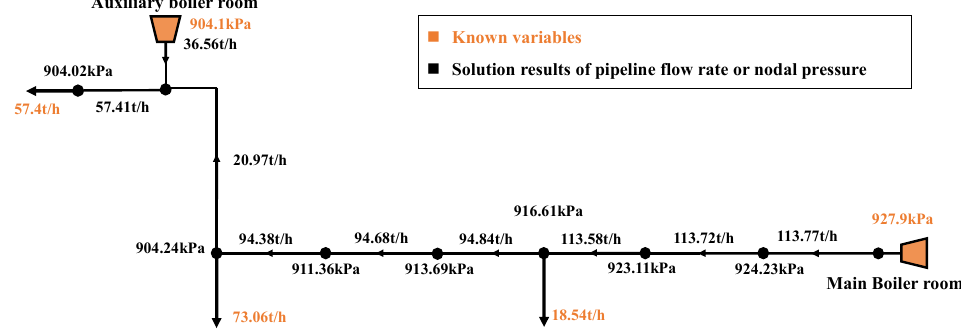
Figure 11. Simulation results of the nine-node double-heat-source tree steam heating network. SynerGEE gas is a relatively accurate commercial simulation software of the thermal system [15]. Using the simulation results of SynerGEE gas as a benchmark, flow verification of the proposed steam network model is carried out. Figure 12 compares the calculation results of the pipeline flow obtained by the proposed model and SynerGEE gas. The absolute error is within 1.6 t/h and the relative error is within 1.5%, indicating that the accuracy of the proposed model is high and can fully meet the simulation requirements.